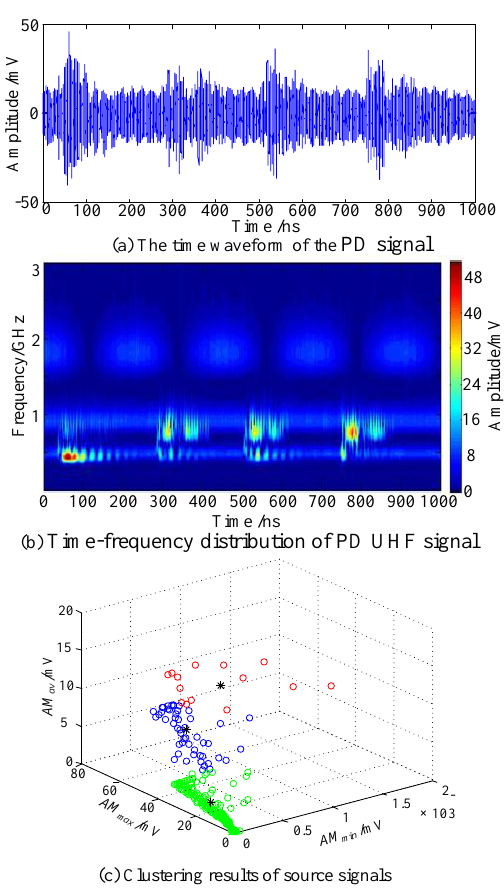
Figure 7. Time–frequency distribution and clustering results of source signals.